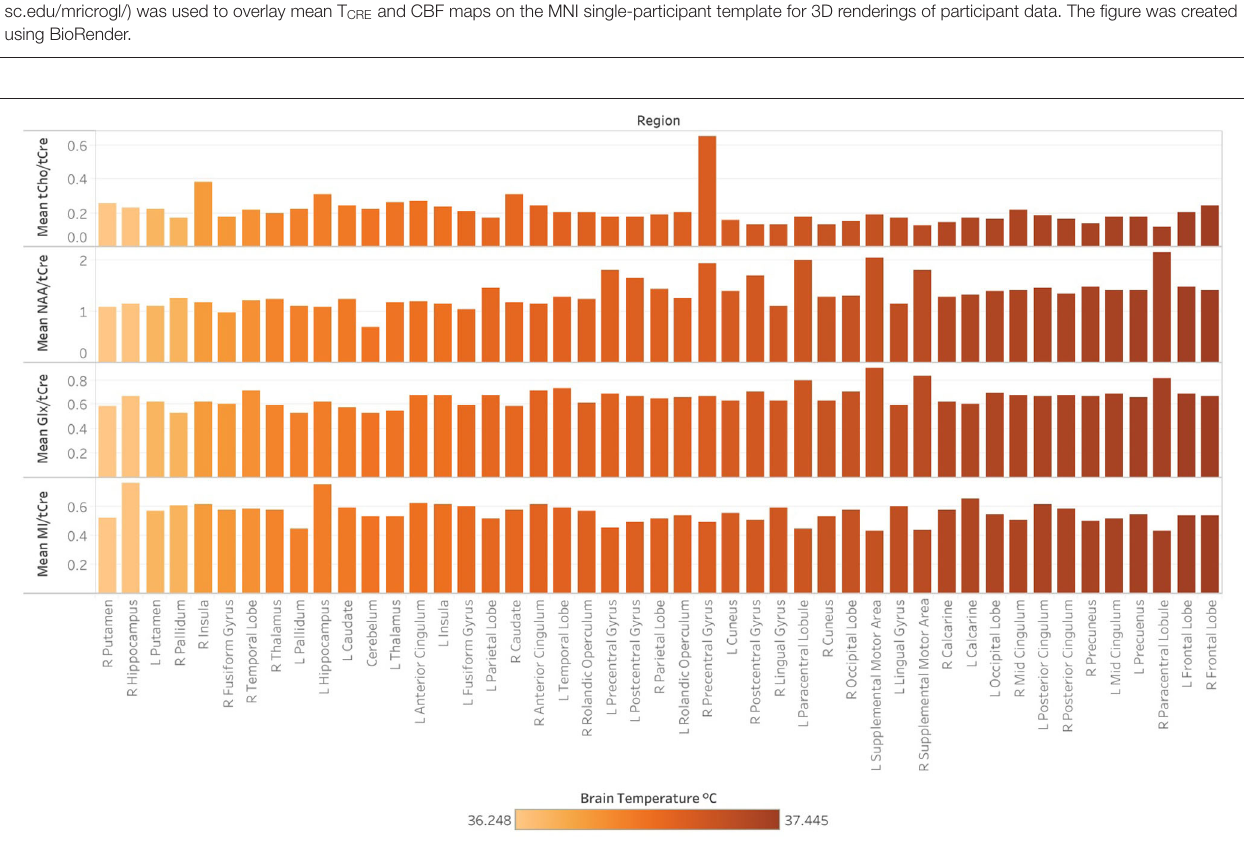
FIGURE 6 | Regional differences in the concentration of major metabolites ratios, as indicated by magnetic resonance spectroscopic imaging (MRSI) data collected at 3-Tesla at a single timepoint (time1). Following the processing of MRSI data within the Metabolite Imaging and Data Analysis System (MIDAS) software package, metabolite ratios were quantified using the Map Integrated Spectrum (MINT) module within MIDAS. Spectral integration was limited to voxels that had a fitted metabolite linewidth between 2 and 12Hz, and voxels were excluded if they had an outlying values of 2.5 times the standard deviation of all valid voxels in the image. Metabolite ratios were derived for 47 brain regions delineated by the Automated Anatomical Labeling (AAL) atlas. Ratios for the following metabolites in reference to creatine (tCre) are demonstrated: choline (tCho), N-acetylaspartate (NAA), Glx (combined signal from glutamine and glutamate), and myo-inositol (MI). Mean tCho/tCre, NAA/tCre, Glx/tCre, and MI/tCRE across regions at time1, with regions ordered (left to right) by ascending mean T CRE at time1 and corresponding coloring metabolite ratio